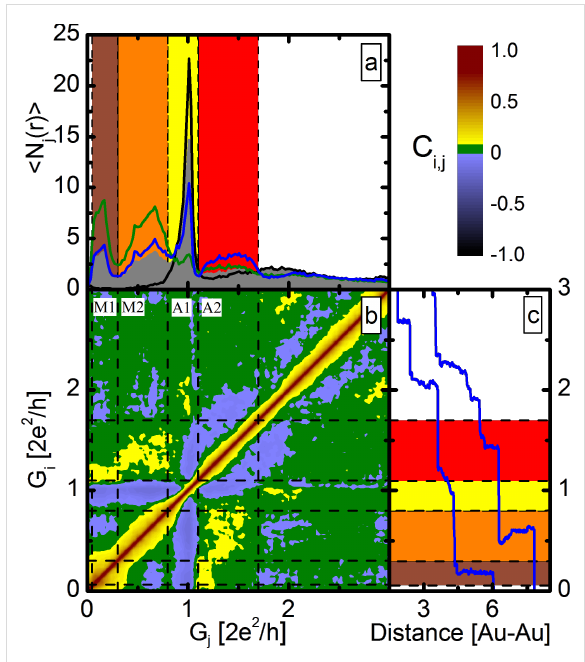
Figure 2: (a) Conditional histograms for selected traces with larger than average length in different regions: M1–M2 (green), A1 (black) and A2 (blue). As a reference the grey area graph shows the histogram for all traces. (b) The 2D correlational histogram of Au–CO junctions. (c) Two demonstrative opening